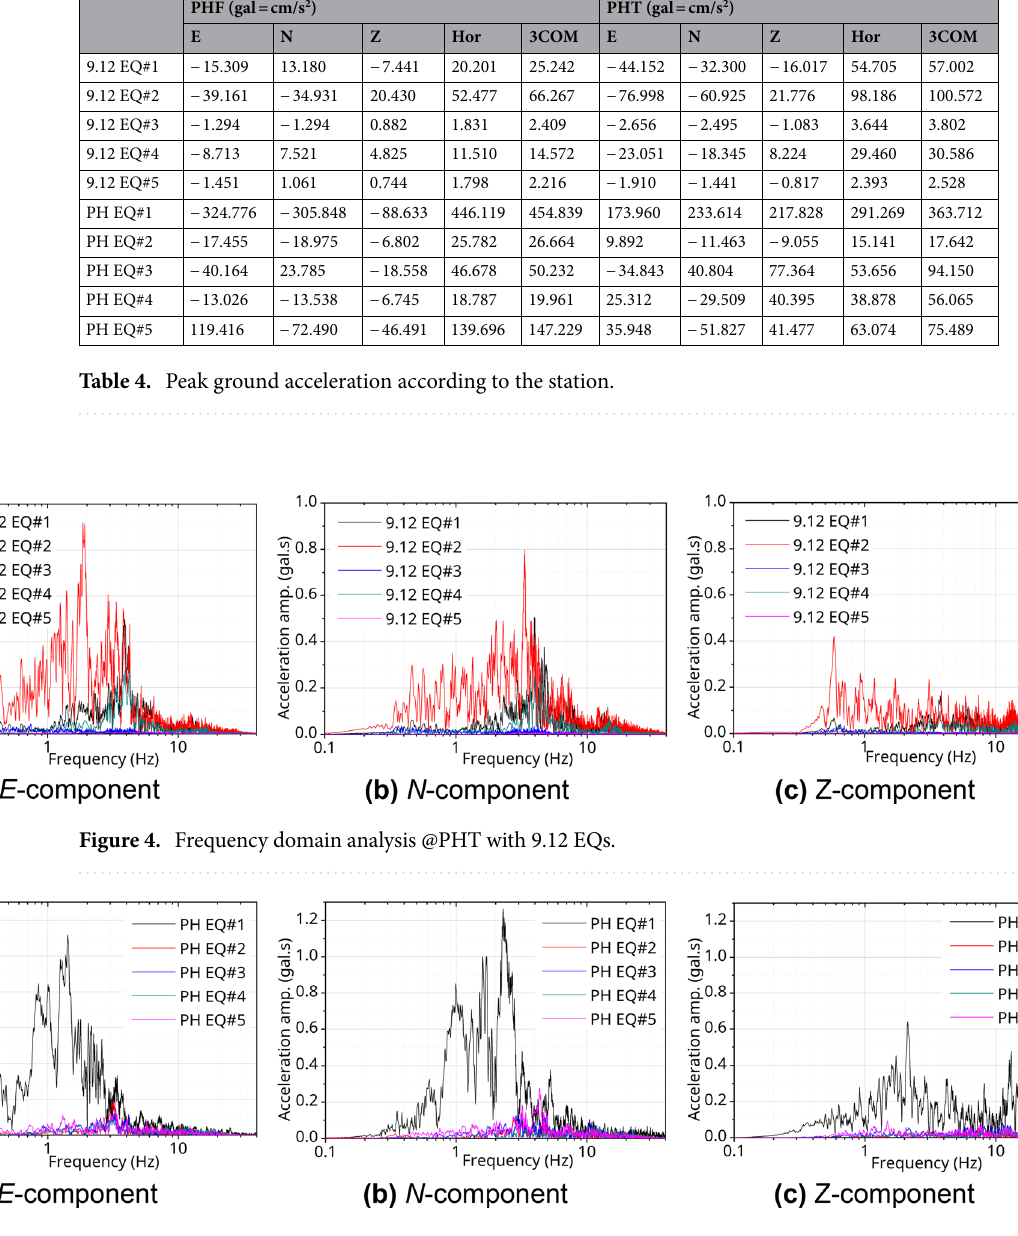
Figure 5. Frequency domain analysis @PHT with PH